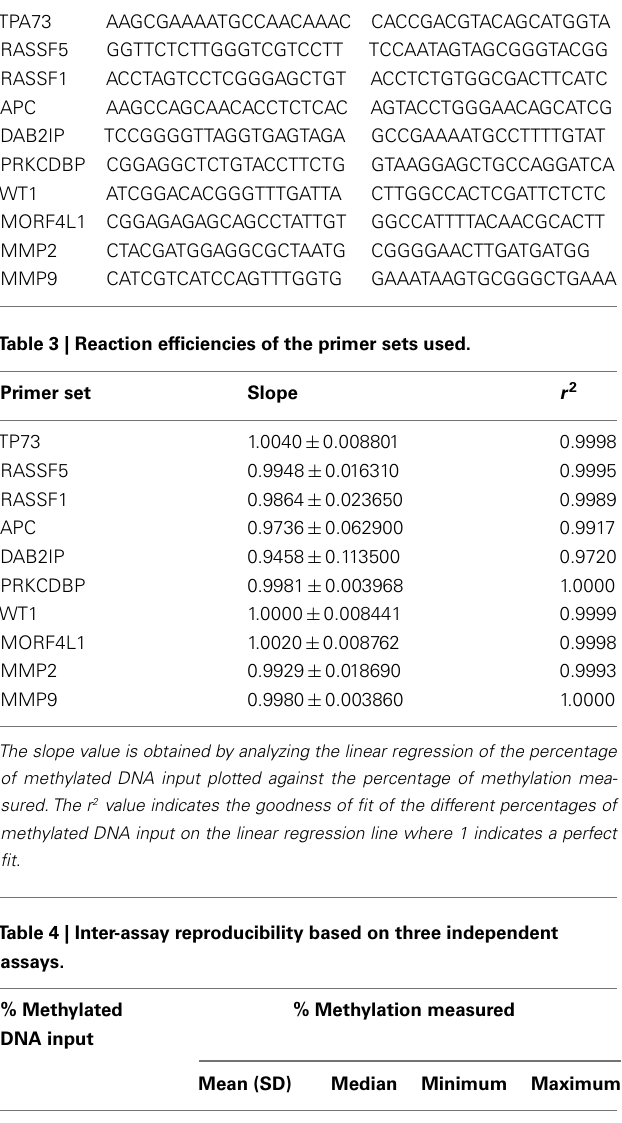
Table 5 | Intra-assay reproducibility showing the positive and negative errors of percentage methylation measured for the four methylated DNA input controls in two independent assays.